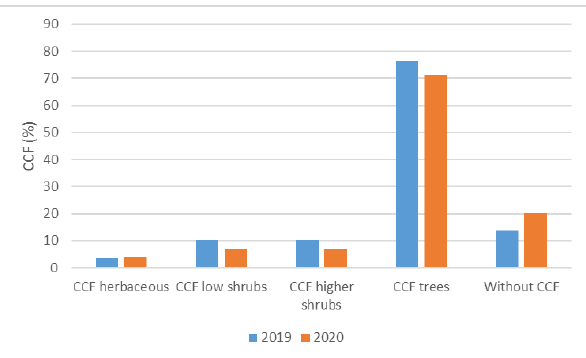
Figure 8 . Fraction canopy cover in both study